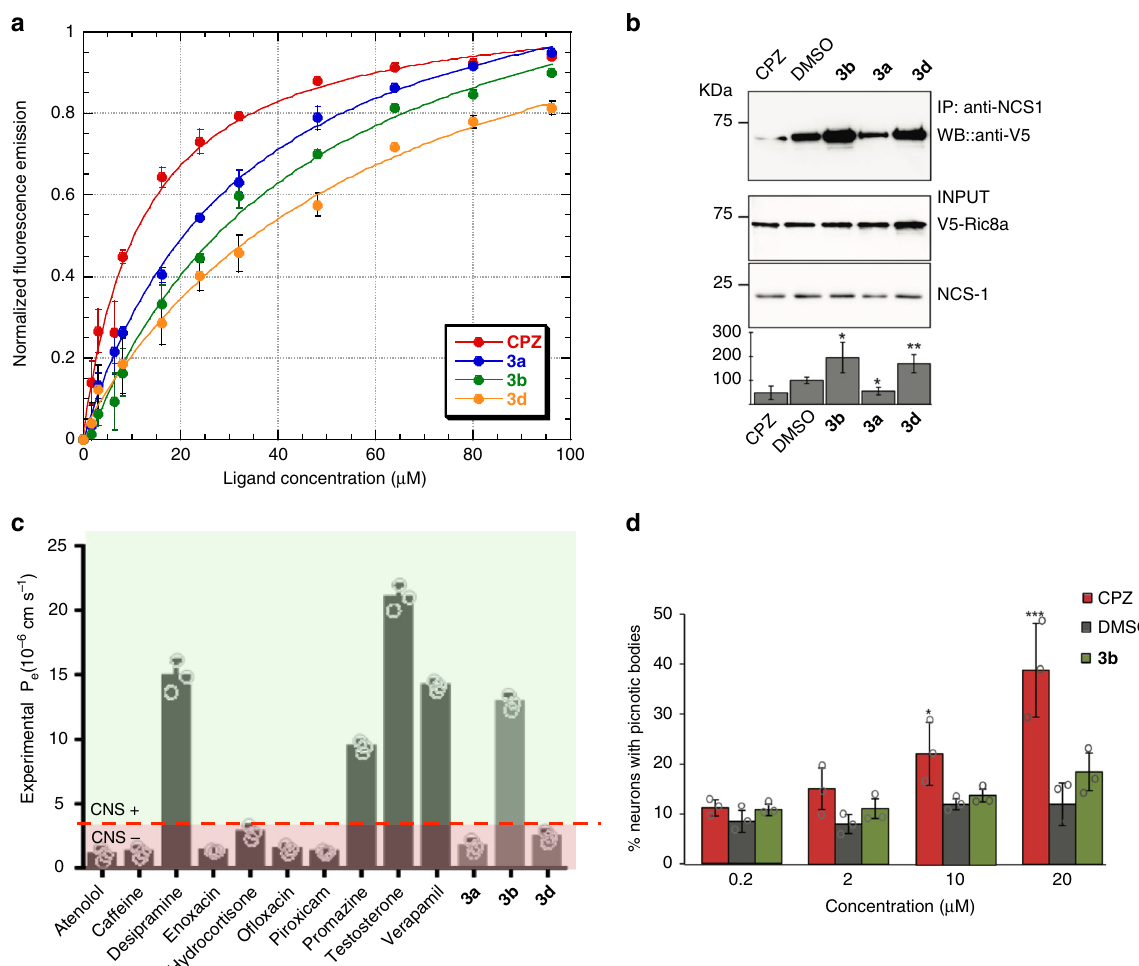
Fig. 6 Protein – ligand binding and toxicity studies. a Representation of the fl uorescence emission of Ca 2 + loaded d NCS1 at increasing concentration of ligand ( 3a – 3d or CPZ). Mean ± SD from three independent experiments. The curves represent the least squares fi tting of the experimental data to a 1:1 stoichiometry. To properly compare the different curves, intensities were normalized and represented. CPZ- d NCS-1 (red dots); 3a -dNCS1 (blue dots); 3b - dNCS-1 (green dots); 3d -dNCS-1 (orange dots). b Co-IP binding assay of human NCS-1 and V5-tagged Ric8a in transfected HEK cells in the presence of CPZ, 3b , 3a , 3d (20 μ M) and the vehicle DMSO. Input represents 1/10 cell lysates before IP. Quanti fi cations of each lane from four experiments are shown below the blots. Bars represent percentage of NCS-1/ Ric8a binding (mean± SD) normalized to DMSO. Note the reduced binding in the presence of CPZ or 3a and the strong binding with 3b or 3d , comparisons are with DMSO which represents basal binding levels (100%). c PAMPA in vitro permeability (P e ) plot of compounds 3a , 3b and 3d and the reference drugs. CNS + (green) for P e > 4.47× 10 − 6 cms − 1 , CNS- (red) for compounds with P e < 4.47 ×10 – 6 cms − 1 . Mean ±SD from three independent experiments. d Cell toxicity assay of CPZ, 3b and the vehicle DMSO as control. Mean ± SD from three independent experiments. Cortical neurons from E14 wild-type mice were treated for 24h with 0.2, 2, 10, 20 μ M of CPZ (red), compound 3b (green) or the same volume of the vehicle DMSO. Then, the percentage of picnotic bodies over the total nuclei was analyzed. Mean ± SD from three independent experiments. Paired two-tailed Student ’ s test ***P ˂ 0.001; ** P <0.01; * P < 0.05. Source data are provided as a Source Data fi le. IP immunoprecipitation, WB western